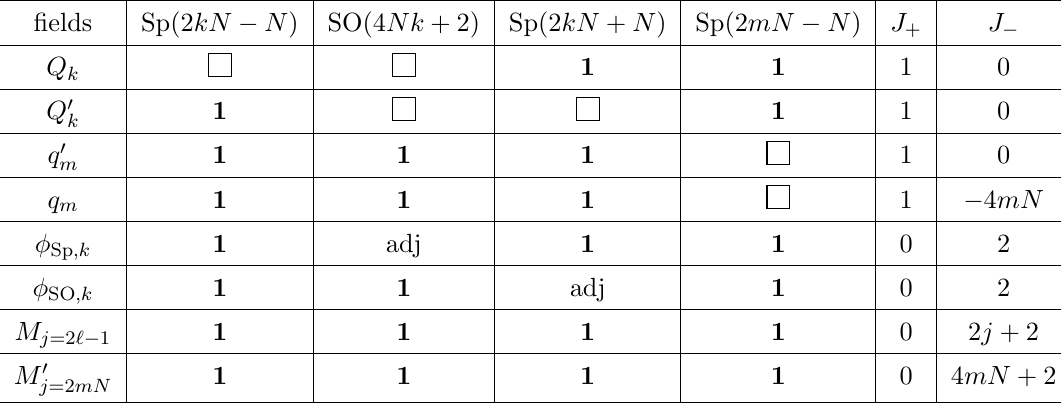
Table 3 . Matter content for the \Lagrangian description" of the ( A 2 m (cid:0) 1 ; D 2 mN +1 ) theory. For the sake of brevity, we have not shown the SO(2) (cid:13)avor symmetry under which q transforms as a doublet. Here k runs from 0 to m (cid:0) 1. At k = 0, SO(4 Nk + 2) ! SO(2), which is the (cid:13)avor symmetry of the theory. The index ‘ in M j =2 ‘ (cid:0) 1 runs from 1 to 2 mN